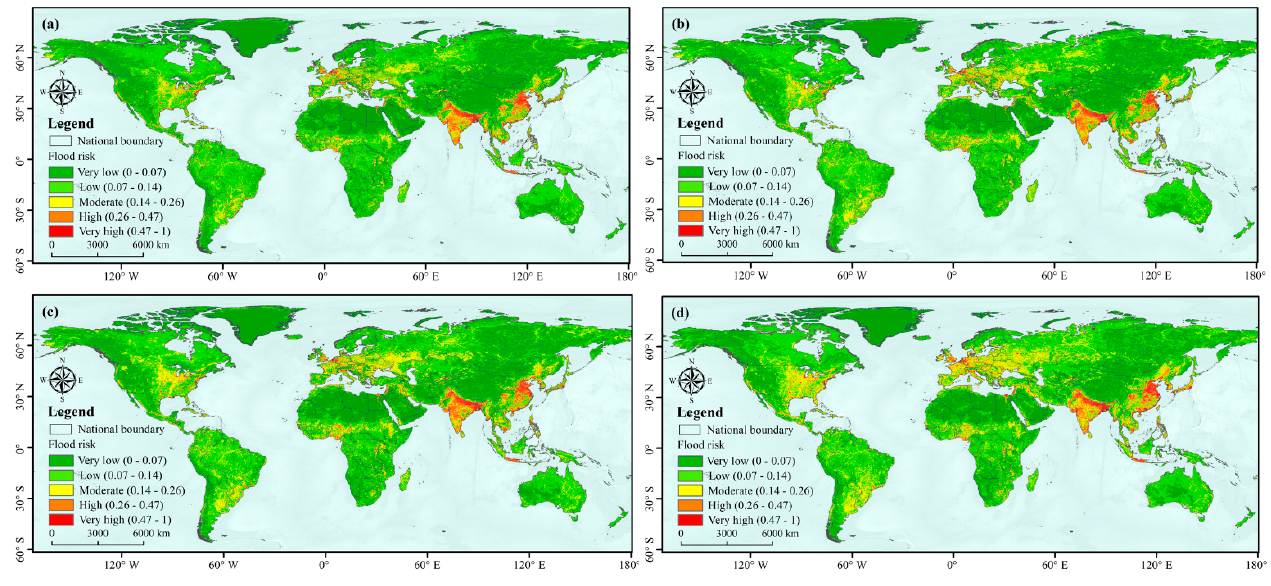
Figure 3. Spatial distribution of global flood risk on a grid scale in ( a ) 2005, ( b ) 2010, ( c ) 2015, and